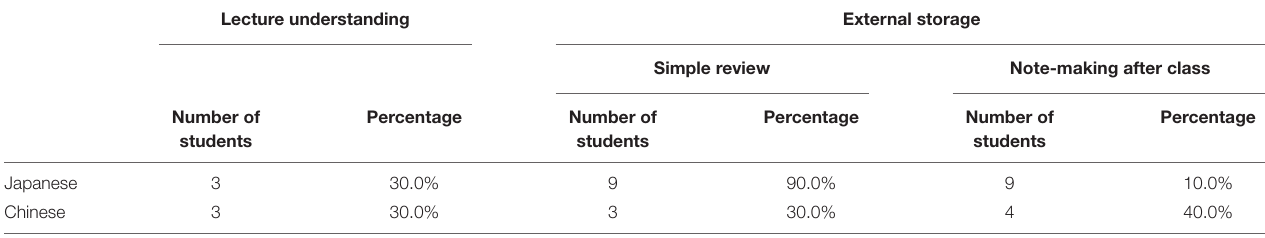
TABLE 5 | Summary of the influence of teachers’ instruction on participants’ note-taking.